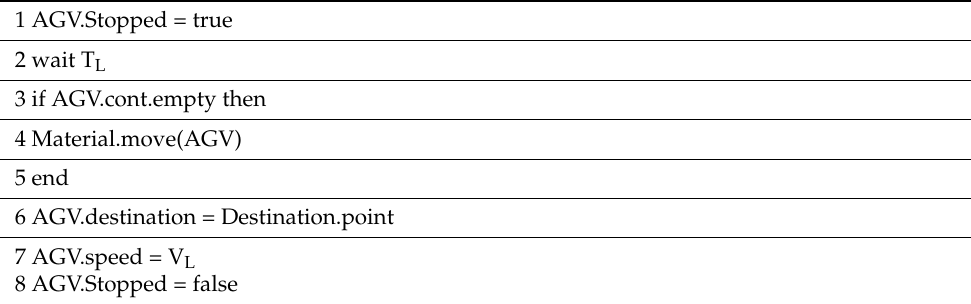
Table 4. Pseudo code of the loading program.